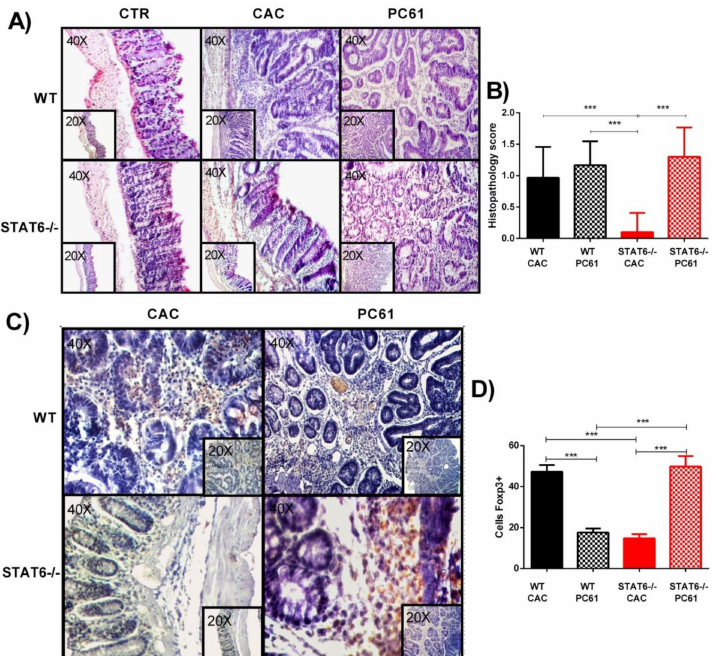
Figure 5. Treatment with anti-CD25 antibody (PC61) favors histological damage in STAT6 − / − mice. ( A ) H&E sections and the histological score ( B ) of the colons isolated from the WT CAC or STAT6 − / − CAC and PC61-treated WT or STAT6 − / − mice at day 77 after the AOM administration. ( C ) A representative example of Foxp3 expression evaluated immunohistochemically in intestinal biopsies of the WT CAC, WT PC61 or STAT6 − / − CAC, and STAT6 − / − PC61 mice at day 77 after the AOM administration. ( D ) The average percentages of Foxp3+ cells in the colon at day 77. The quantification of Foxp3+ cells was performed using ImageJ software v.1.48 by counting cells in 10 high-powered fields in at least three slides per animal. The sections of tissue were analyzed at 20 × and 40 × using an optical microscope. The data are expressed as the mean ± SEM and are representative of two independent experiments, with at least three mice per group per day of the analysis. *** p <